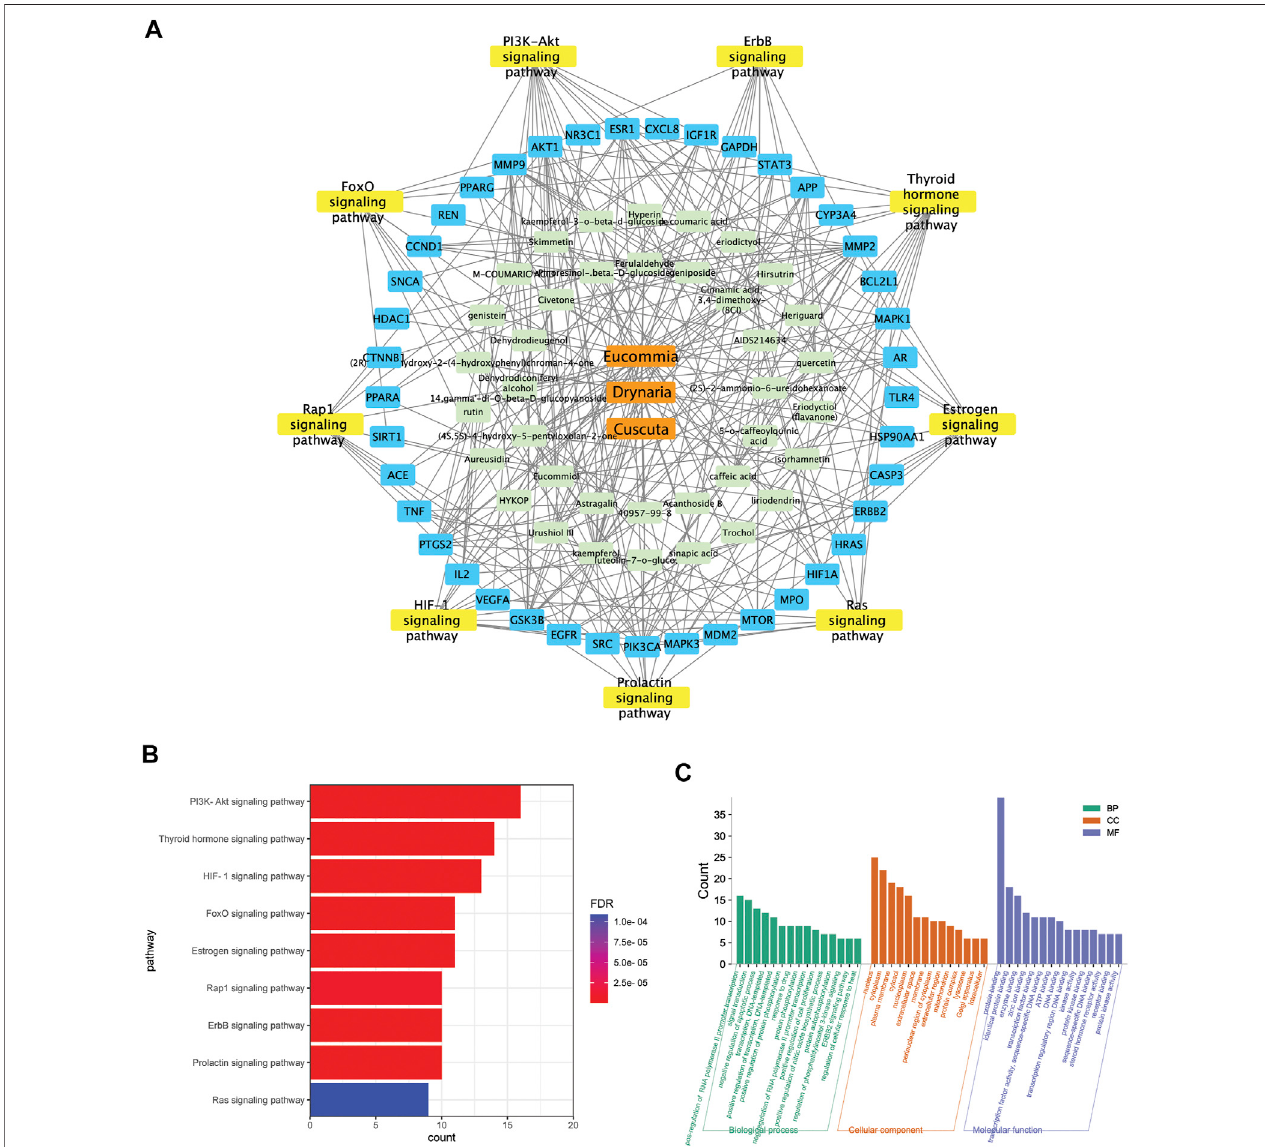
FIGURE 7 | The integrated network pharmacology analysis indicated the potential targets mediated by E.C.D. extracts in treating osteoporosis. (A) E.C.D. extracts – constituent – osteoporosis related targets – pathway network. (B) The potential pathways in treating osteoporosis by E.C.D. extracts performed by KEGG enrichment analysis. p < 0.05, the count of enrichment related targets decreases from top to bottom. (C) The biological process (BP), molecular function (MF), and cellular components (CC) analysis of targets mediated by E.C.D. extracts. p < 0.05, the count of related targets decreases from left to right.